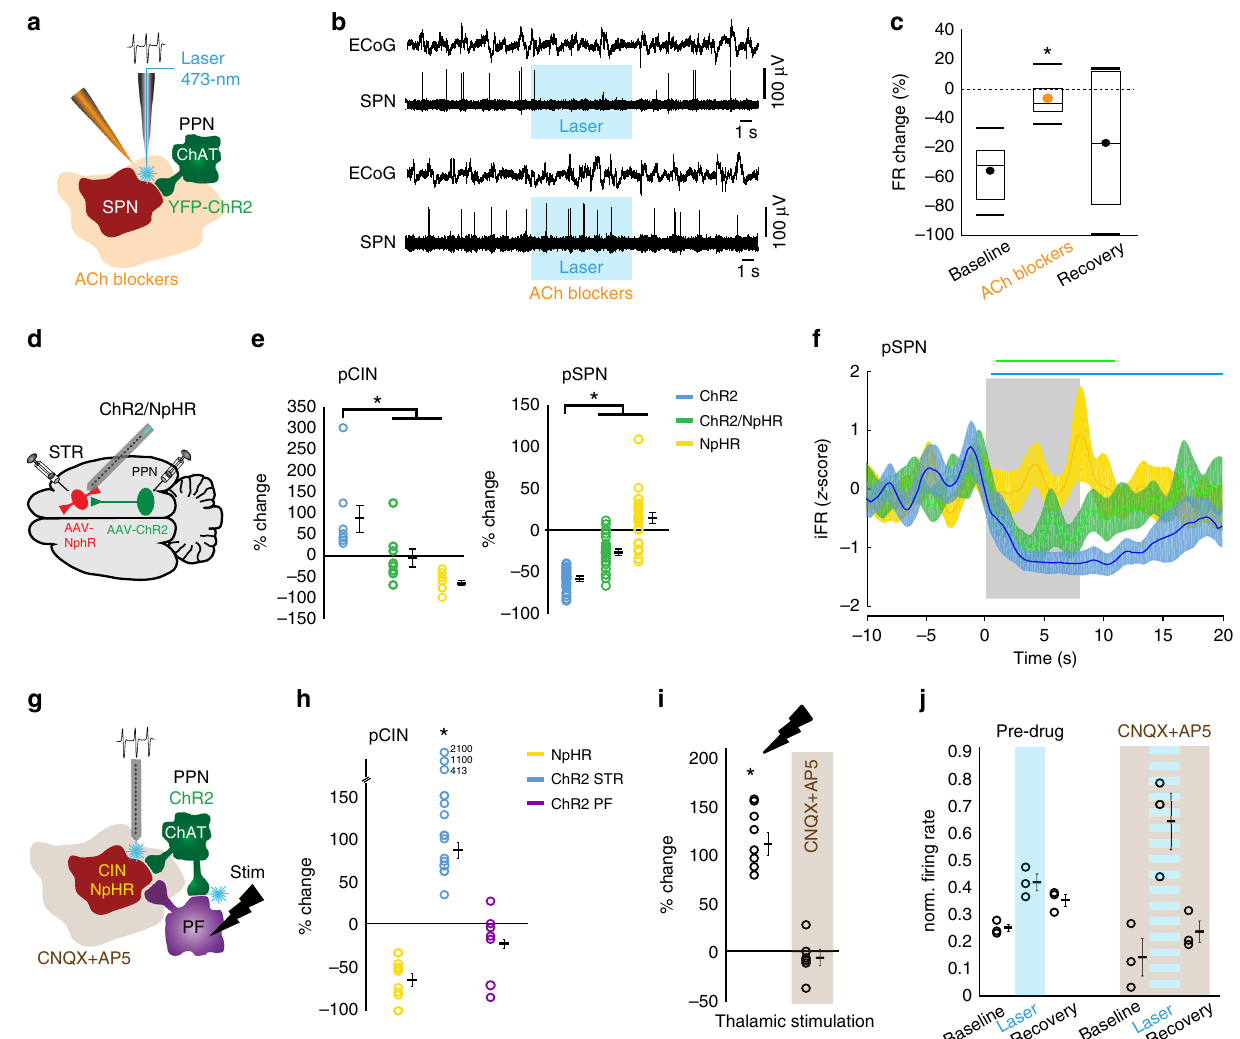
Fig. 5 Optogenetic and pharmacological dissection of PPN and LDT effects. a Schematic of the in vivo optogenetic and acetylcholine antagonists experiment design. b, c pSPNs decreased their activity during ChR2-PPN activation but not in the presence of cholinergic blockers ( n = 7 neurons, n = 7 rats; one-way ANOVA F (2,20) = 5.24, P = 0.0161; Bonferroni post hoc analyses: before / during P = 0.014, before / after P = 0.611, during / after P = 0.221). d In vivo optogenetic experiment design where ChR2 was transduced in the midbrain and halorhodopsin (NpHR; AAV-DIO-NpHR3.0-mCherry) in the striatum ( n = 7). e pCINs ( n = 8) and pSPNs ( n = 33) fi ring rate changes during stimulation of ChR2, NpHR, or both. pCINs activity was signi fi cantly higher during ChR2 activation than during NpHR activation or both (ChR2: + 83.10 ± 32.09%; NpHR: − 71.19 ± 5.61%; ChR2/NpHR: − 6.97 ± 22.22%; one-way ANOVA F (2,23) = 11.59, P = 0.0004). pSPNs activity was signi fi cantly lower during ChR2 compared to NpHR and ChR2/NpHR (ChR2: − 85.07 ± 1.38%;